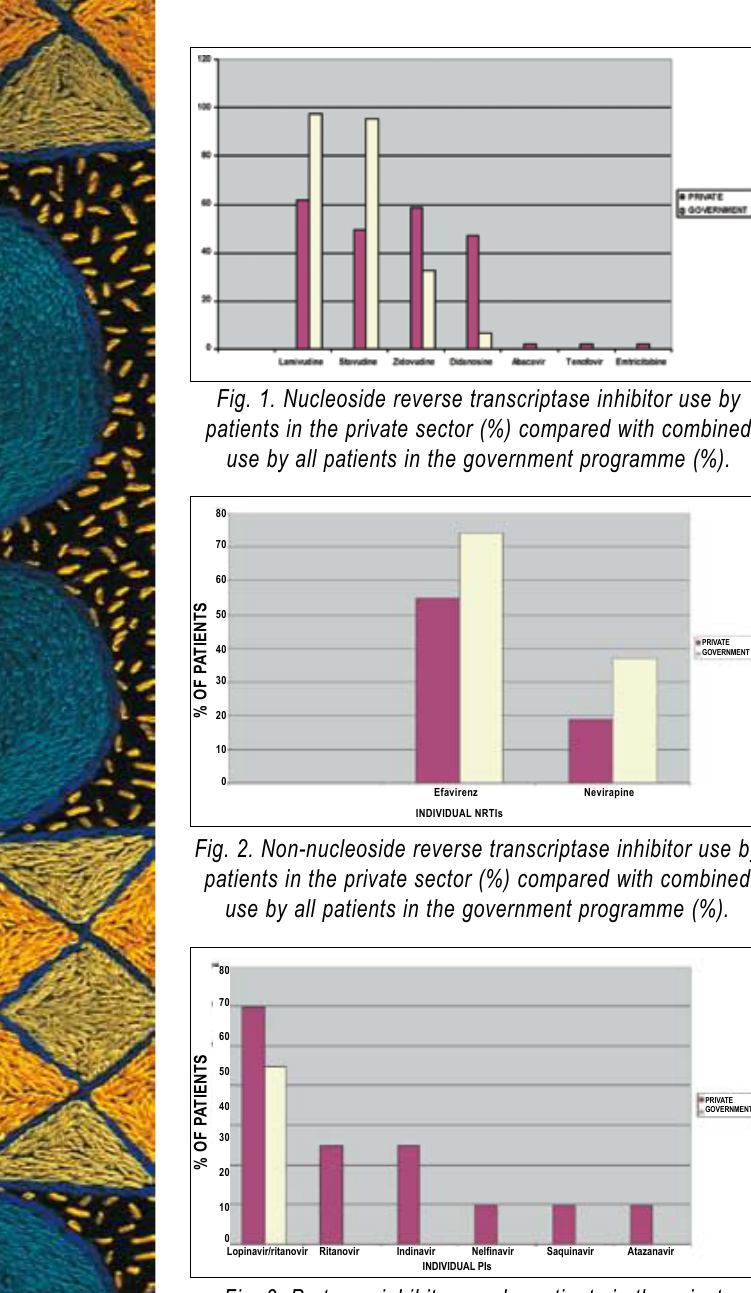
Fig. 3. Protease inhibitor use by patients in the private sector (%) compared with combined use by all patients in the government programme (%).